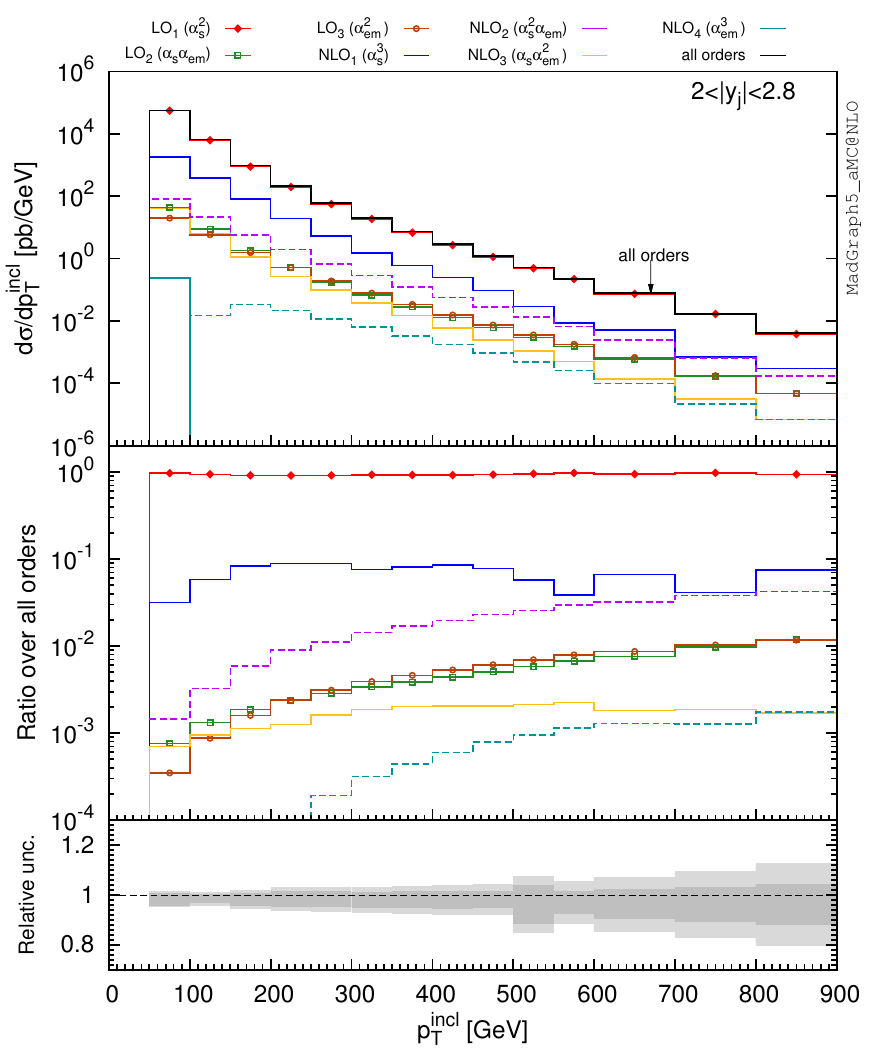
Figure 8 . Single-inclusive transverse momentum, for 2 < j y j (cid:20) 2 :